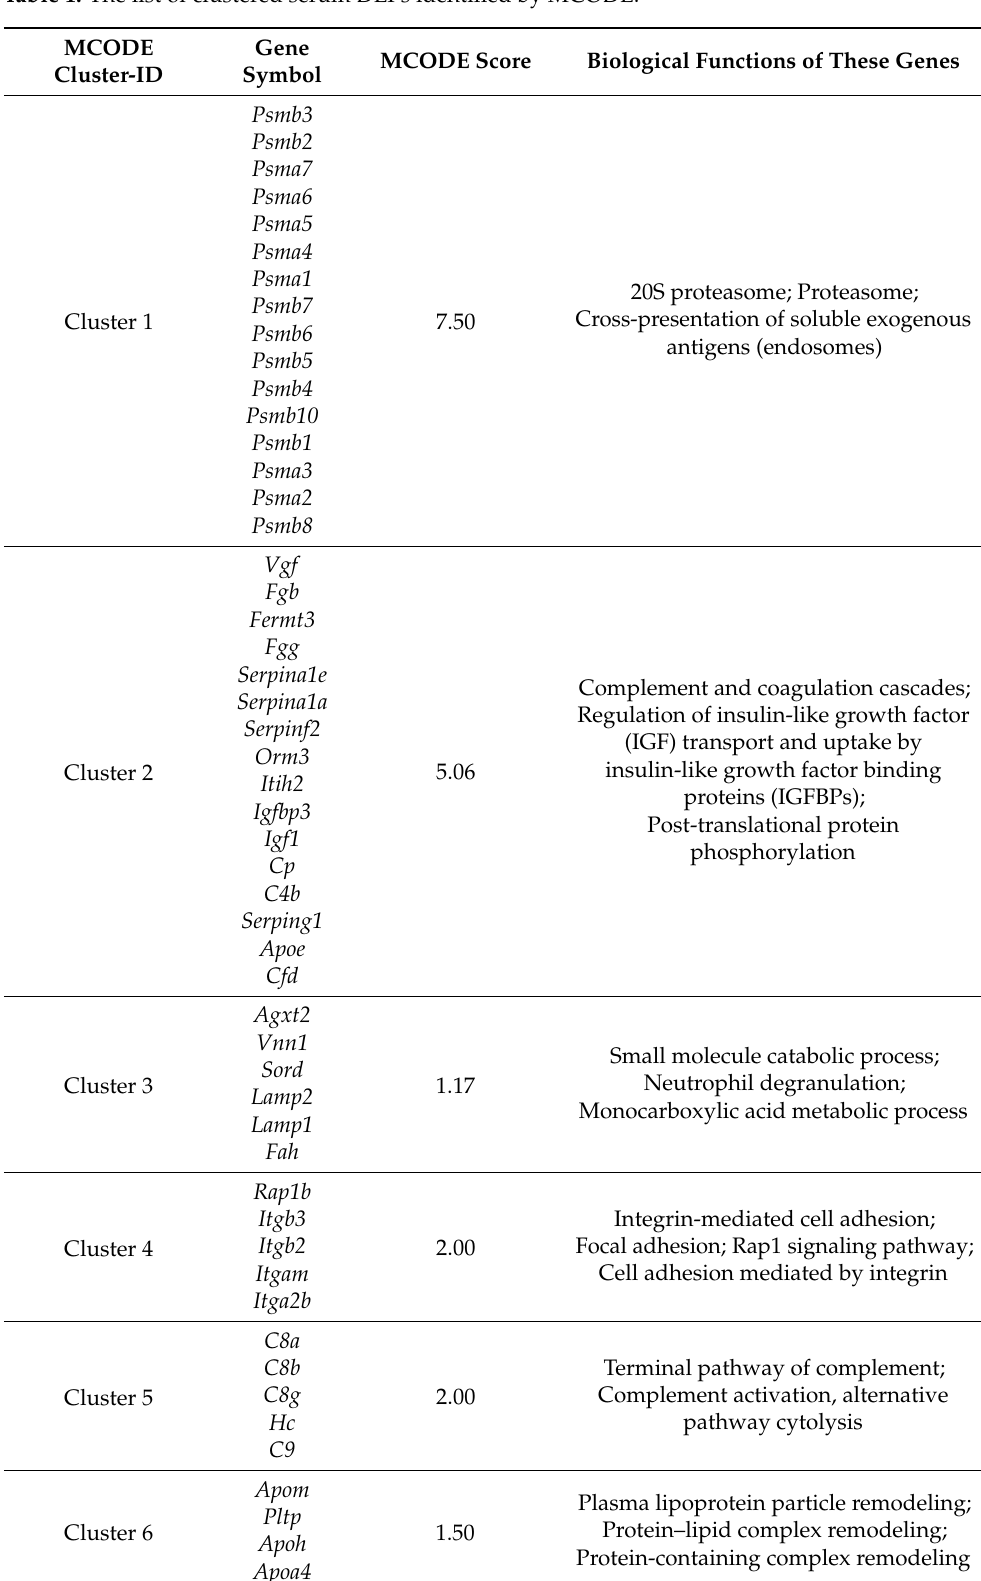
Table 1. The list of clustered serum DEPs identified by